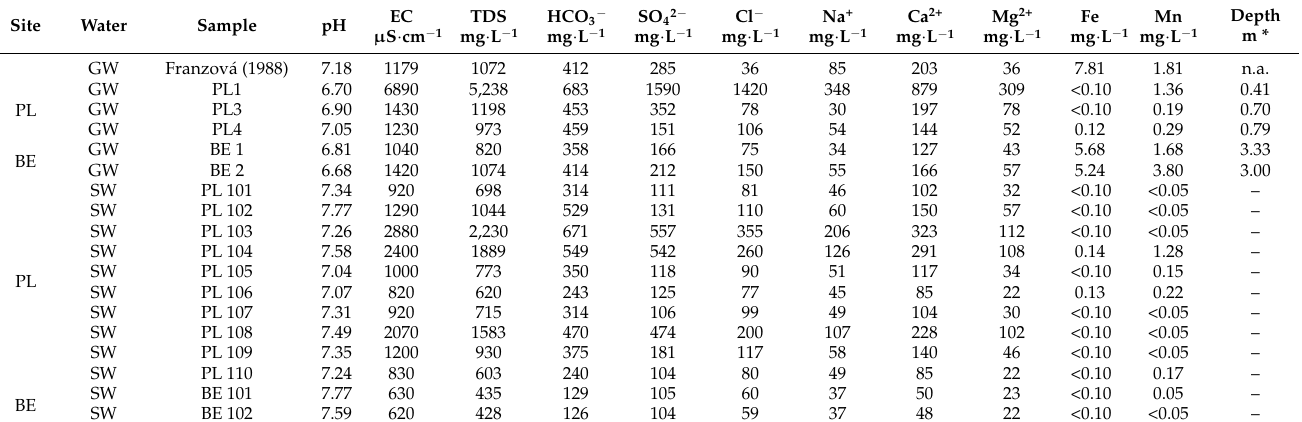
Forests 2021 , 12 , x FOR PEER REVIEW * Measured vertically from the water level to the soil surface; altitude differences between the zero levels of the hydrogeological wells and the soil surfaces across the corresponding study sites were ≤ 1.0 m.